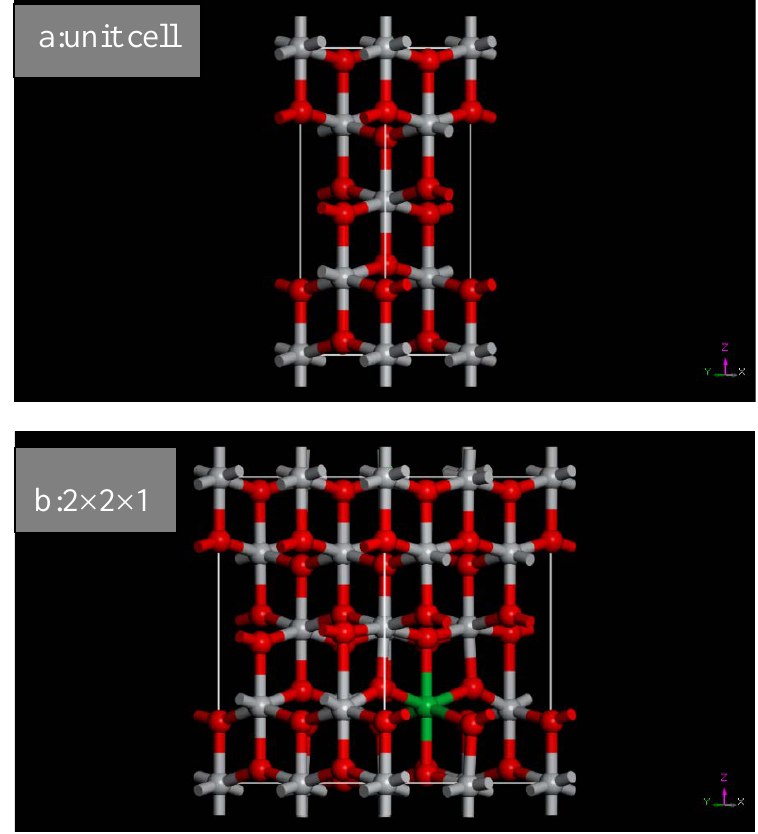
Figure 1. Pure anatase TiO 2 (( a ), unit cell) and anatase RE/TiO 2 (( b ), supercell). The red, gray and green spheres represent oxygen, titanium and rare-earth atoms, respectively.